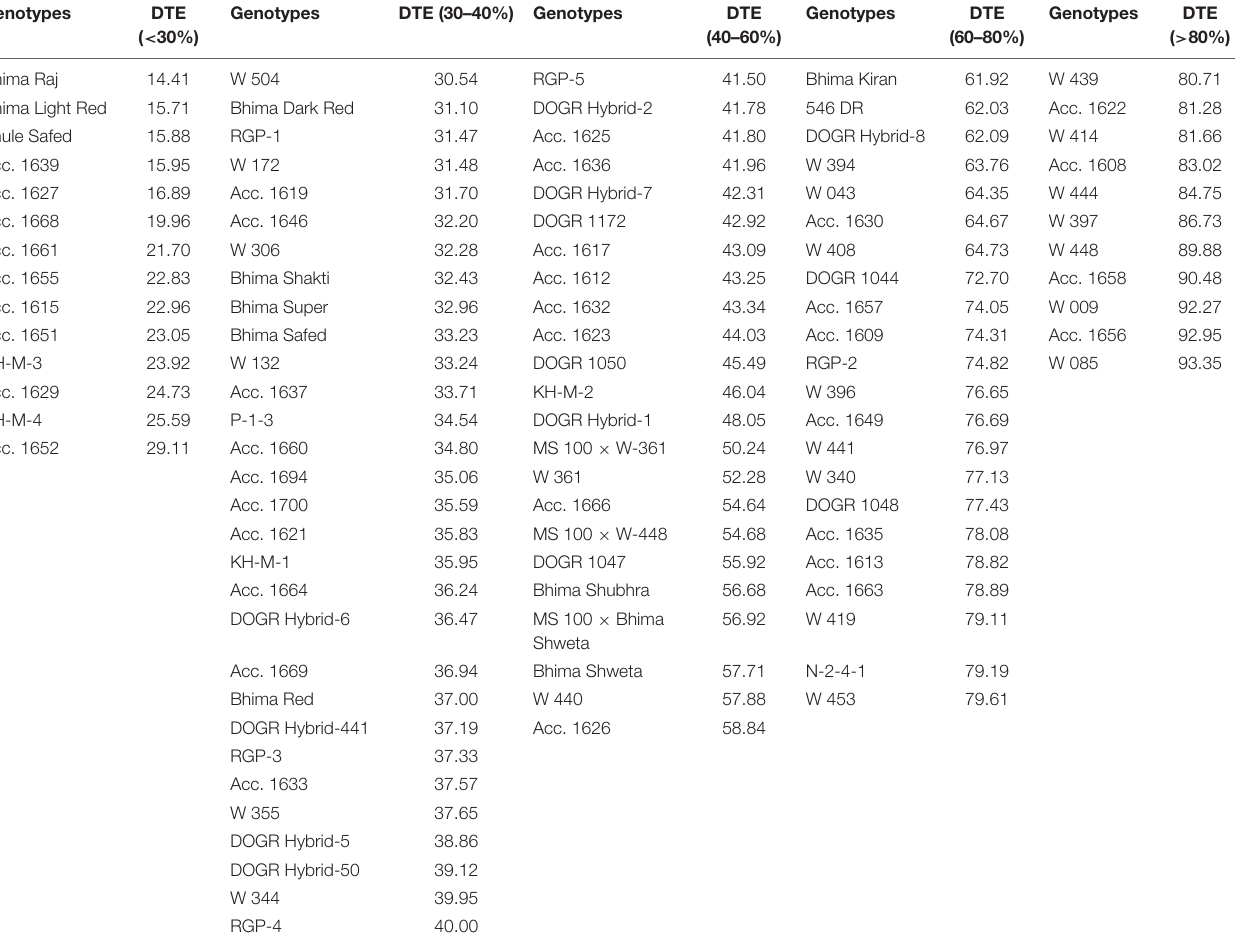
TABLE 2 | Genotypes grouped based on drought tolerance efficiency (DTE %). Genotypes